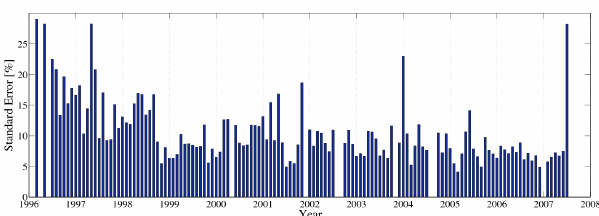
Figure 13. Sampling standard error. The histogram represents the standard error of the cirrus 2 Fig. 13. Sampling standard error. The histogram represents the stan- clouds occurrence shown in Figure 14. It is based on the duration of the lidar acquisition per 3 dard error of the cirrus clouds occurrence shown in Fig. 14. It is month. 4 based on the duration of the lidar acquisition per